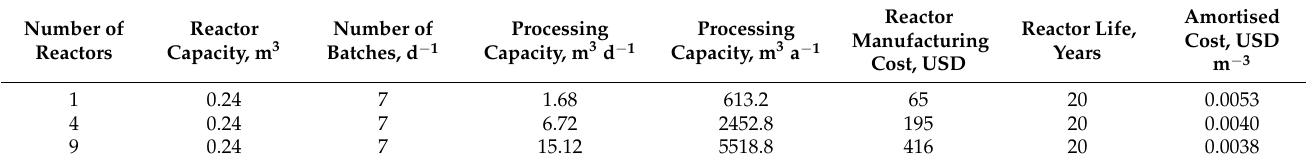
Table 2. Reactor manufacturing costs.